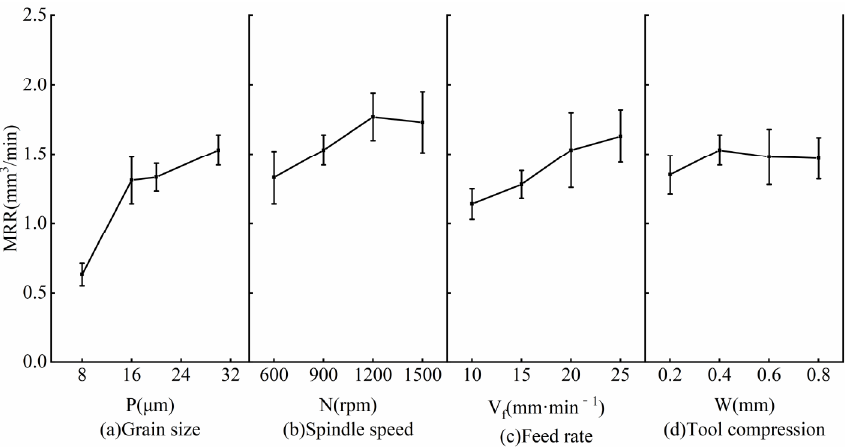
Figure 5. Influence of grinding parameters on material removal rate: ( a ) Grain size, ( b ) Spindle speed, ( c ) Feed rate, ( d ) Tool compression.